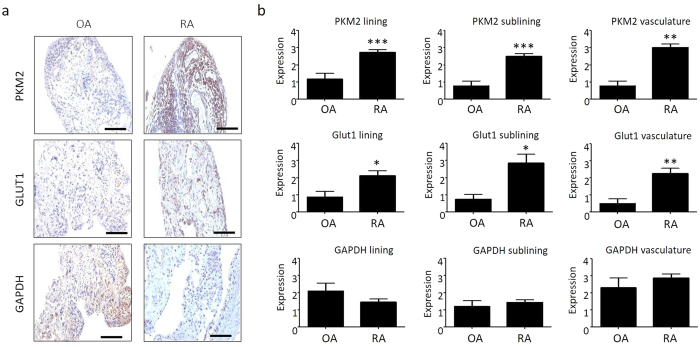
The RA synovium is more metabolically active than OA in vivo.(a) Representative photomicrographs demonstrating PKM2, Glut1 and GAPDH expression in RA (n = 25) and OA (n = 12) synovium. Mag10X for PKM2, Glut1, GAPDH. Scale bars in the bottom right hang corner represent 100 μm. (b) Representative bar graphs demonstrating semi-quantification of immunohistochemical staining of glycolytic markers PKM2, Glut1 and GAPDH in RA (n = 25) and OA (n = 12) lining, sublining and vasculature layers of synovial tissue. Data was analysed using Mann Whitney test and is represented as Mean ± SEM, *p < 0.05, **p < 0.01, ***p < 0.005 significantly different to control.